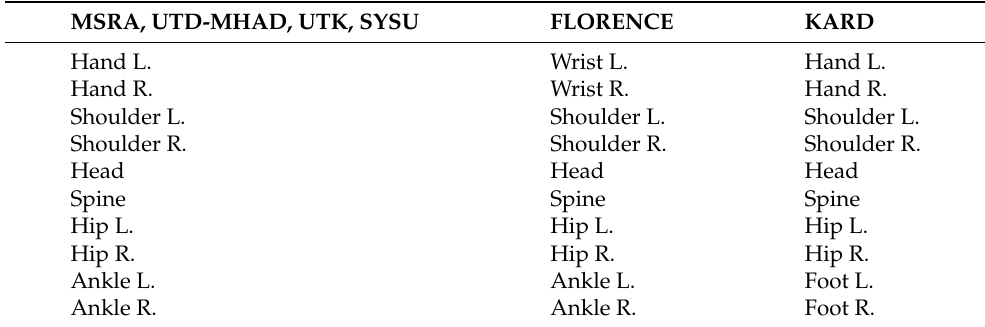
Table 3. Subsets of bones used for the Bone Pair Descriptor. “L.” and “R.” denote Left and Right,